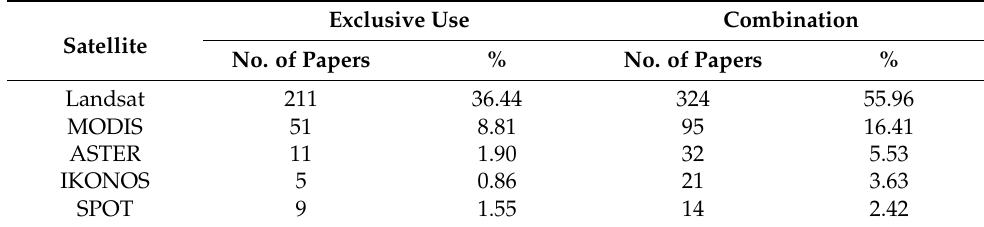
Table 7. Most used satellites sensors in the LULC estimation.